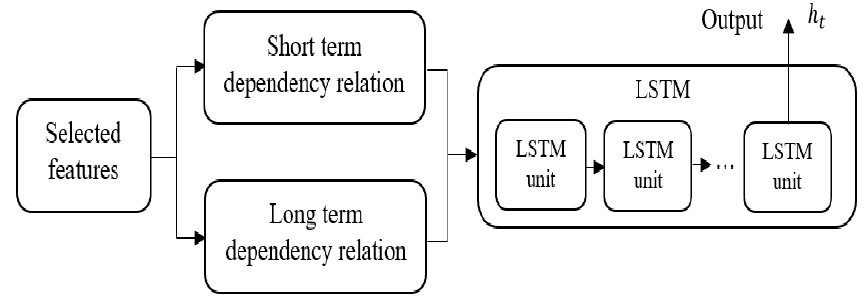
Figure 4. Graphical presentation of the LSTM network.